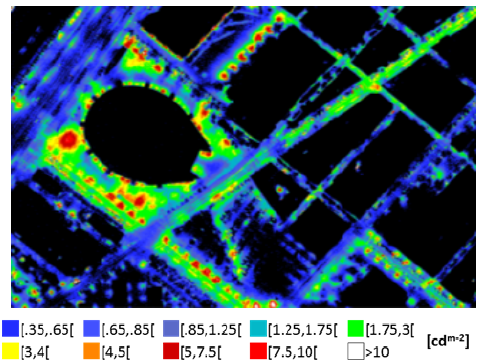
Figure 2. High resolution luminance map derived from the hyperspectral sensor and photogrammetric camera fusion. Segmentation in 10 classes